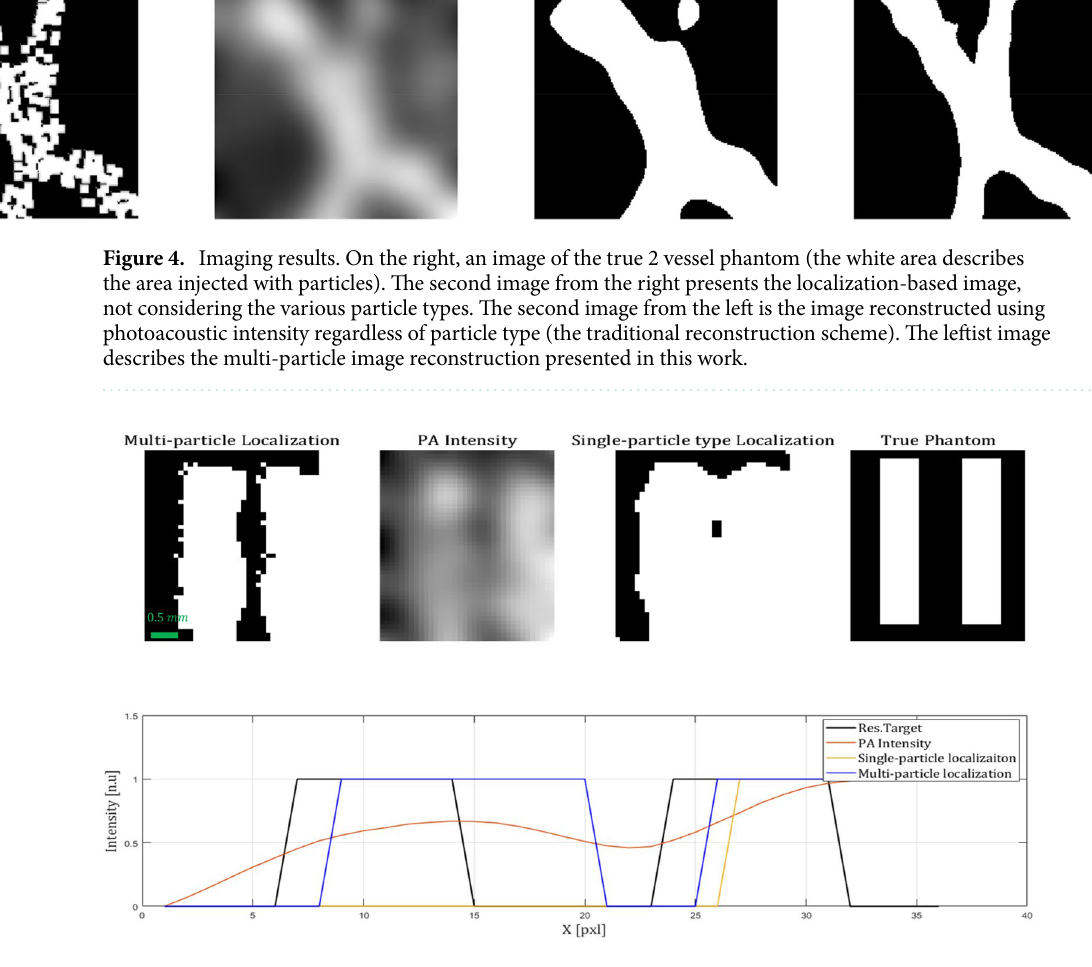
Figure 5. Resolution target. The real phantom, as well as the three reconstruction methods described above, are presented. The lower image describes a single line from the middle of each image, demonstrating the resolution